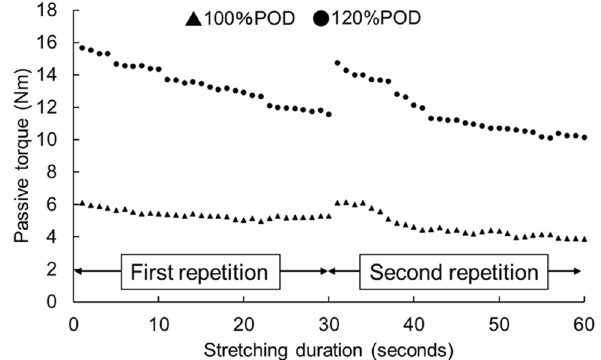
Figure 1. Passive torque during stretching